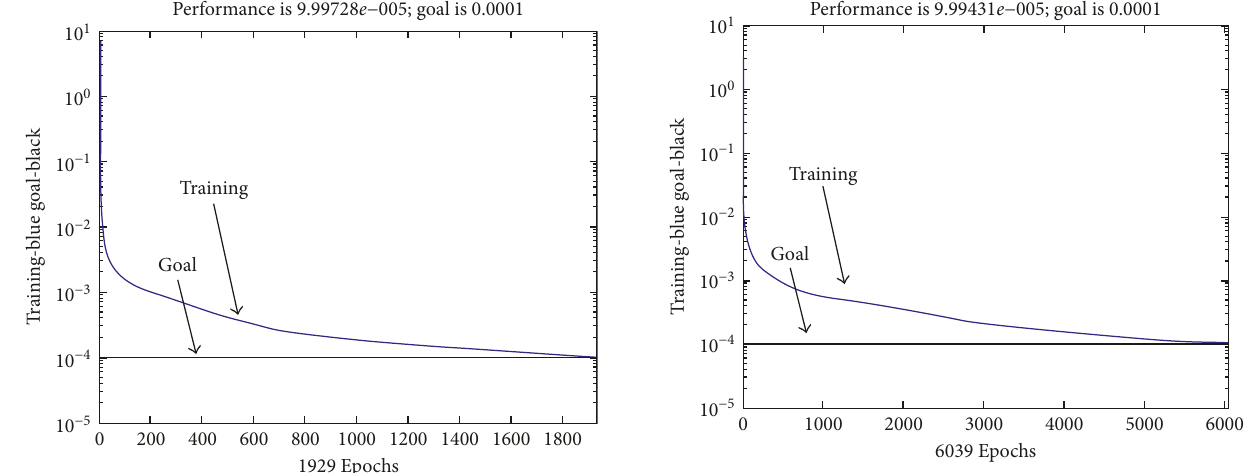
Figure 13: Training performance for the Polak–Ribiere conjugate gradient backpropagation algorithm of ANN.